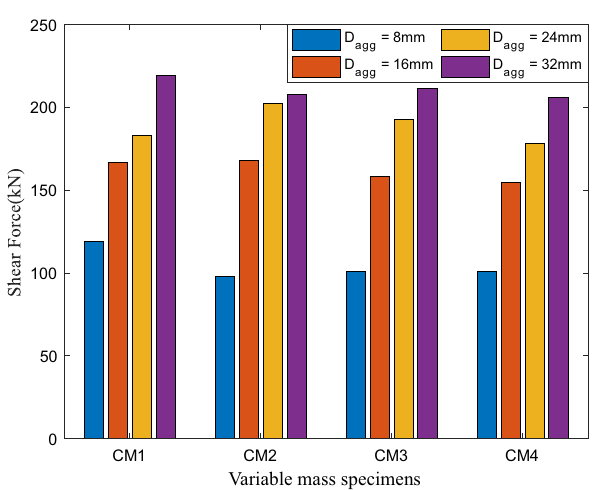
Fig. 15 Average post-peak shear force on the critical section under variable impact